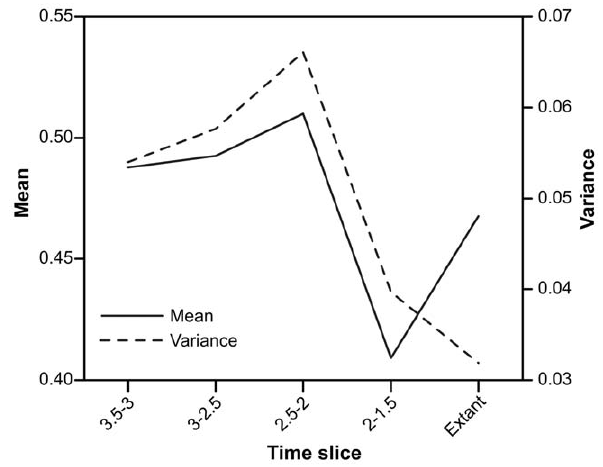
Figure 7. Inter-point mean and variance through time. Diagram showing changes in the mean (solid line) and variance (dotted line) inter-point distance in carnivoran morphospace through time.